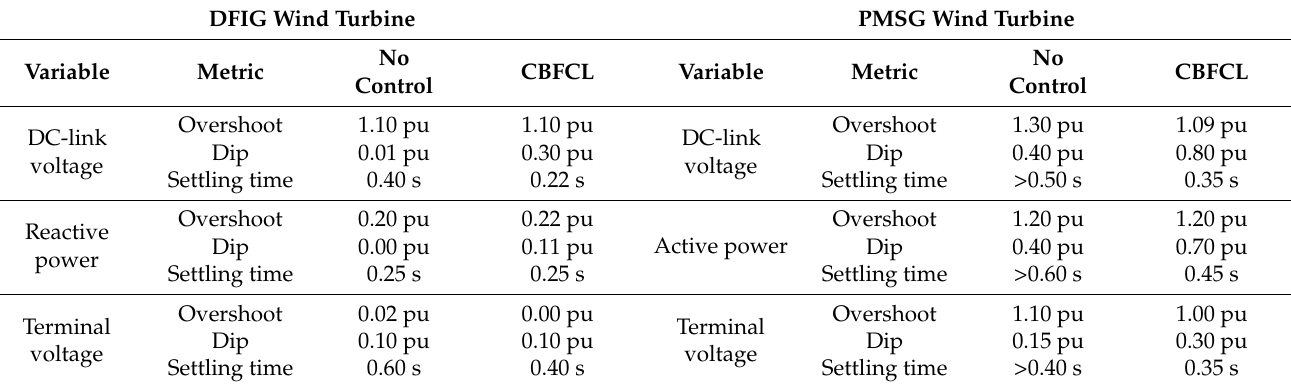
Table 4. Numerical Index Performance of the Wind Turbines considering